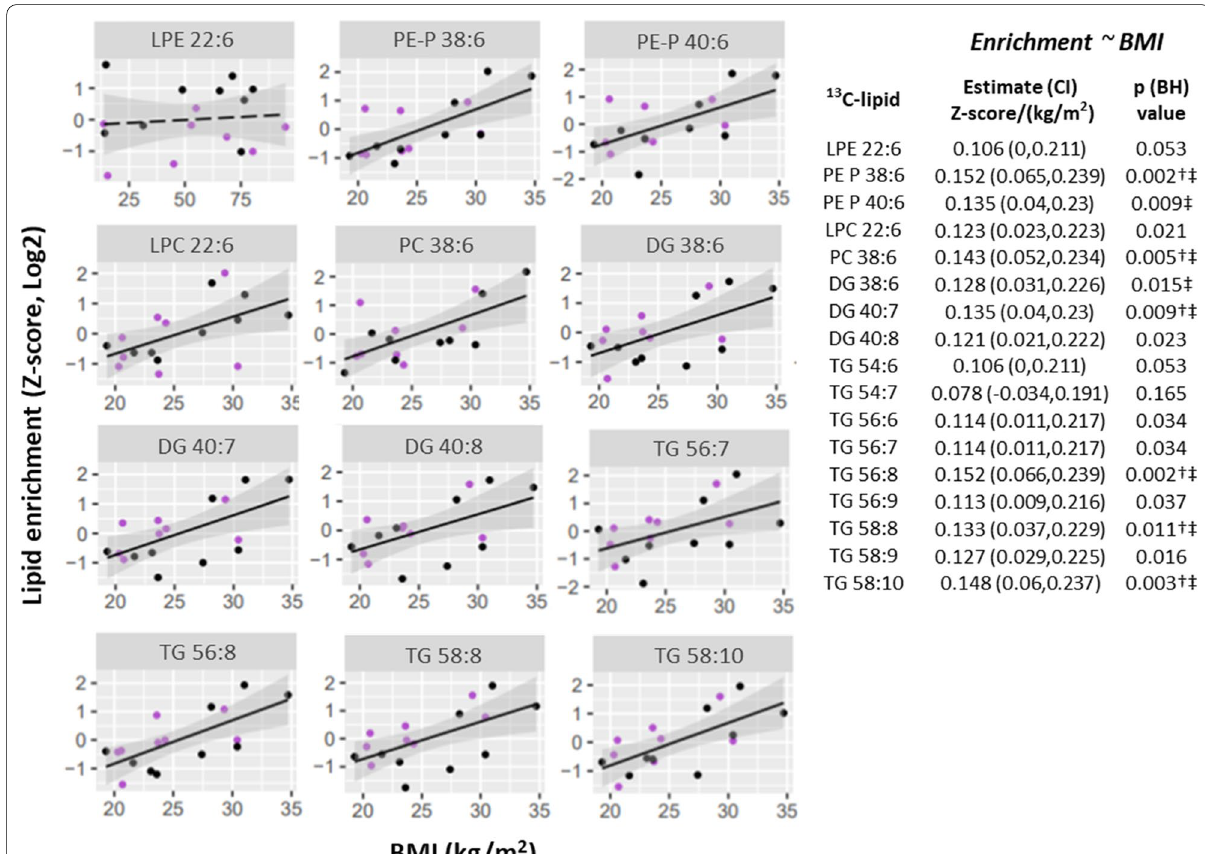
Fig. 2 Positive associations of BMI with the enrichment of placental 13 C‑DHA lipids (Z‑scored, log2 transformed; n physiological glucose condition (5 mmol/L). Linear regression was run with lipid as the outcome and BMI as the predictor. The Benjamini–Hochberg (BH) method was used to correct for multiple testing. Solid lines show significant associations while dashed lines show non‑significant associations. Shaded areas show 95% confidence intervals. Key for dots—Purple: non‑GDM, Black: GDM. † Significant after adjusting for fasting glycemia, ‡ Significant after adjusting for 2 h glycemia. CI confidence interval, DG diacylglycerol, DHA docosahexaenoic acid, GDM gestational diabetes, LPC lyso‑phosphatidylcholine, LPE lyso‑phosphatidylethanolamine, PC phosphatidylcholine, PE-P phosphatidylethanolamine‑plasmalogen,